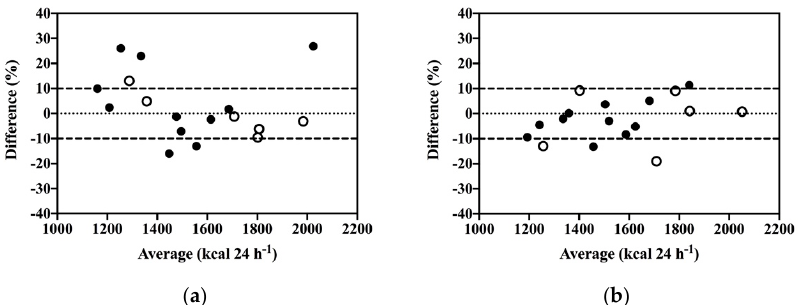
Figure 4. Bland–Altman analysis of agreement between measured resting energy expenditure via indirect calorimetry and predicted energy expenditure via the Mifflin-St Jeor equation during pre ( a ) and post assessments ( b ). IFT ( n = 11) closed circles; CET ( n = 6) open circles. J. Clin. Med. 2021 , 10 , x FOR PEER REVIEW